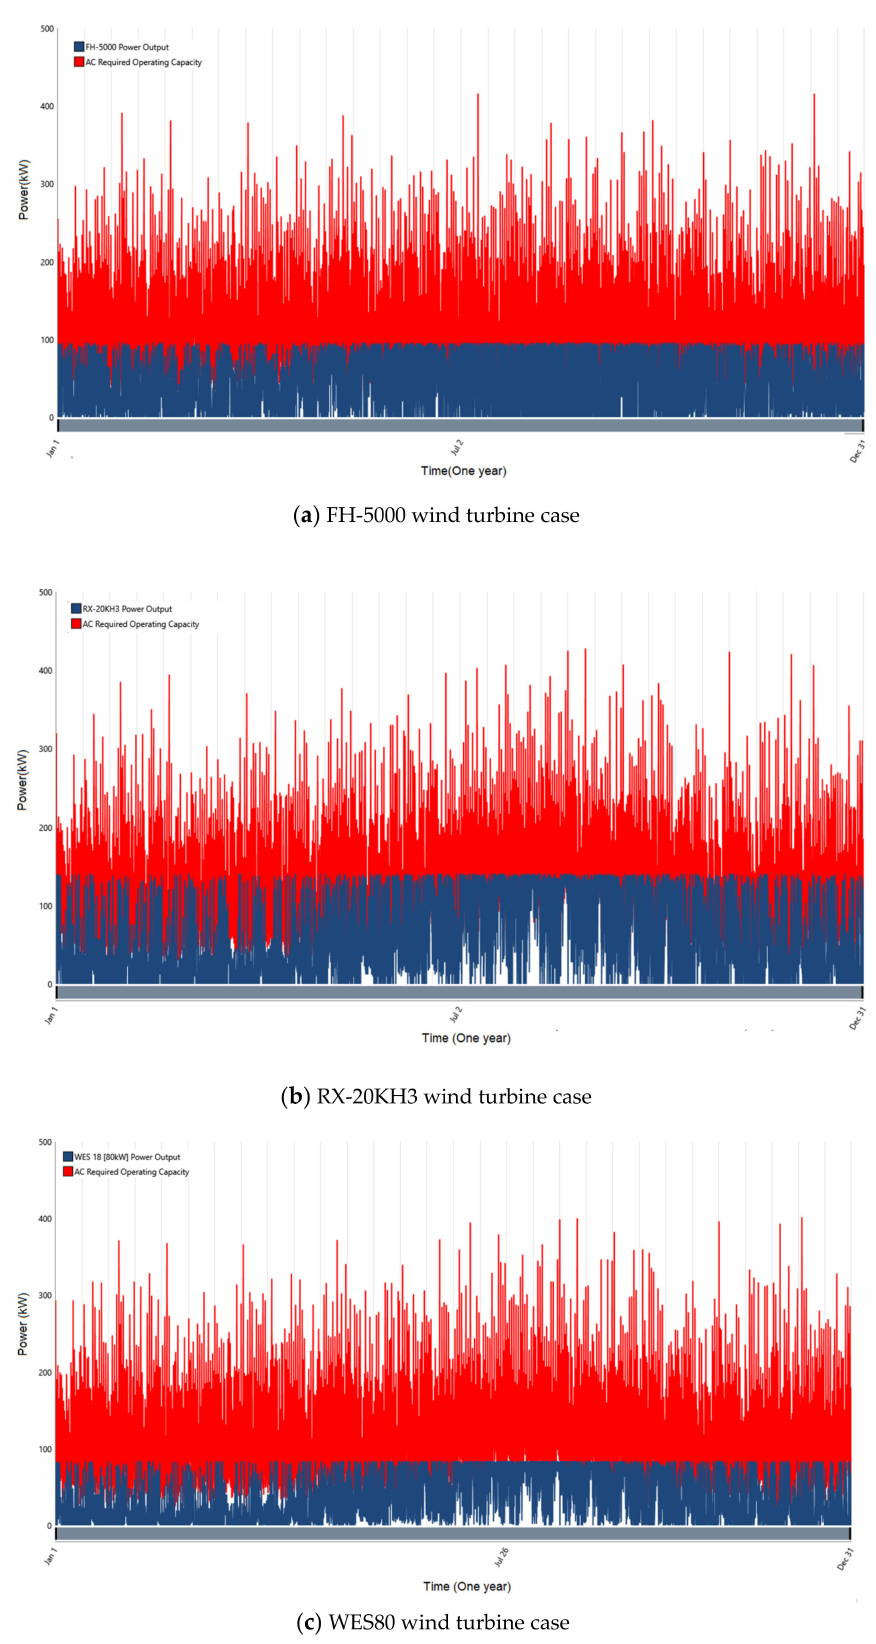
Figure 13. Yearly required power and wind farm penetration in